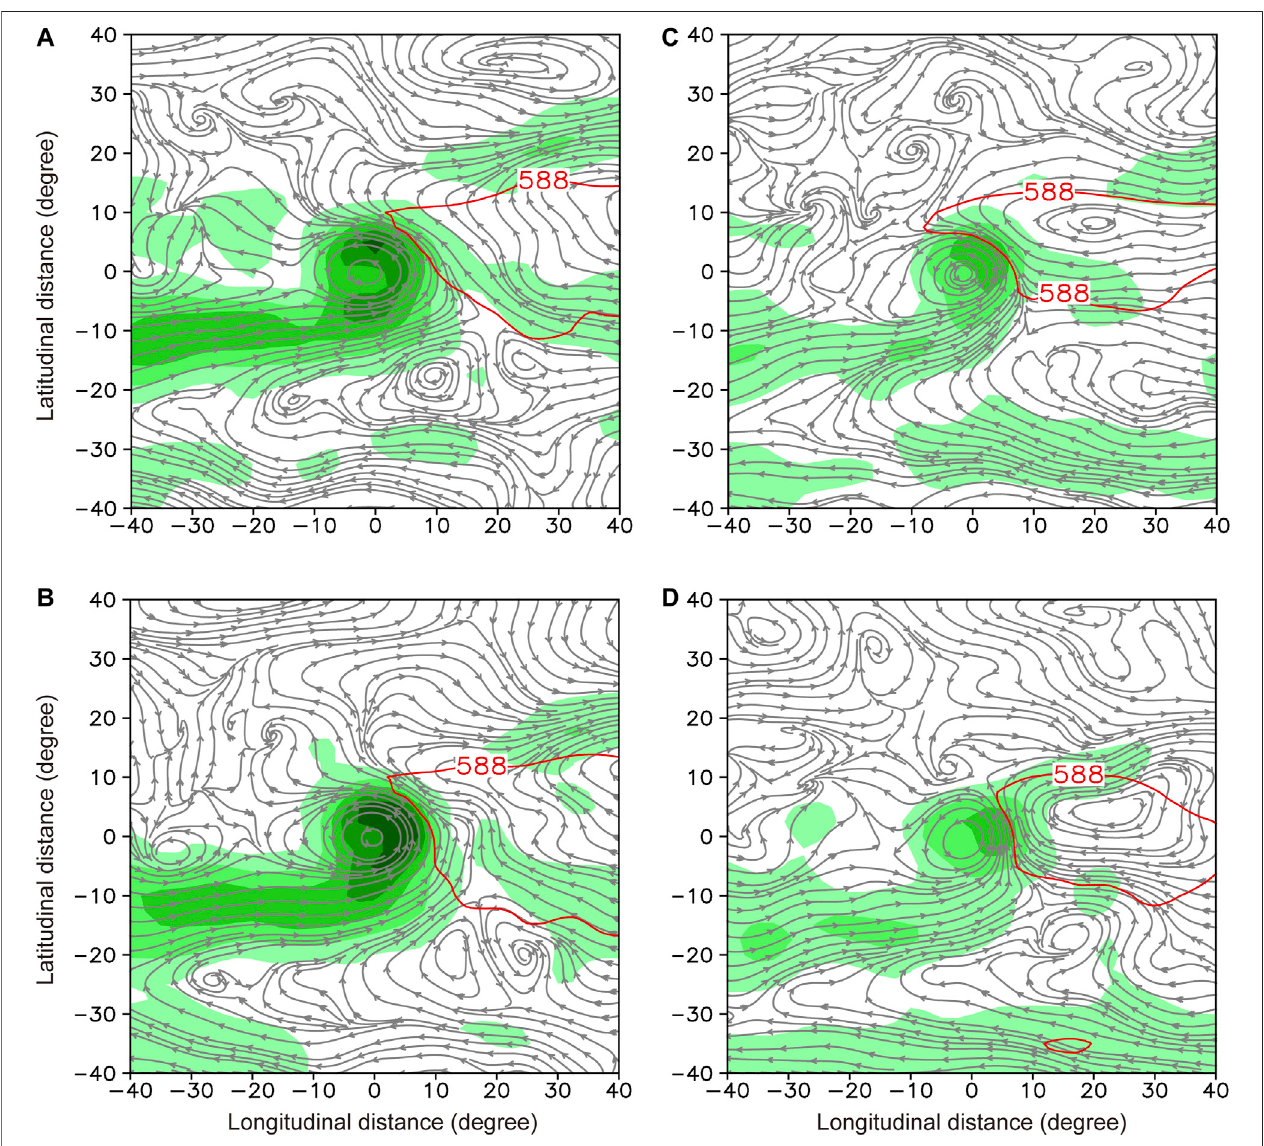
FIGURE 6 | Streamlines, magnitude of water vapor fl ux at 850-hPa (shaded; units: kg m − 1 s − 1 ) and 588-dagpm contours (red line) at 500-hPa of the composited (A, B) ERLTC and (C, D) NERLTC 1 day before (A, C) and on the day (B, D) of the extreme or non-extreme rainfall. The meaning of the coordinates is the same as in Panel 3